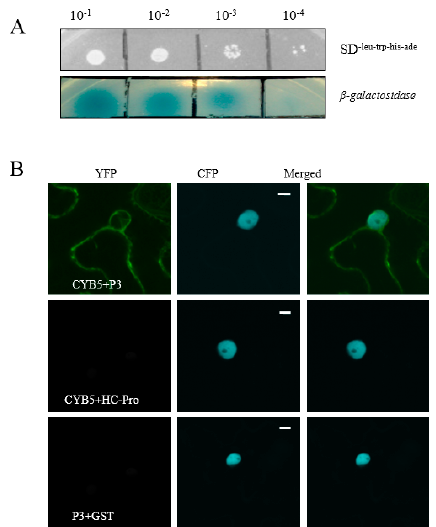
Figure 1. GmCYB5-1 interacts with the P3 protein of soybean mosaic virus (SMV). ( A ) Interaction of SMV-P3 and GmCYB5 in yeast growing on selective medium SD -leu-trp-his-ade with X- α -gal at different concentrations. Images are representative two independent experiments for each interaction. ( B ) Bimolecular florescence complementation (BiFC) micrographs of 40 × magnification at 48 h post-infiltration from plants co-expressing nYFP-GmCYB5 and cYFP-P3, with cYFP-HC-Pro and cYFP-GST are negative controls. Transgenic Nicotiana benthamiana, expressing CFP-H2B (nuclear localized histone 2B), were used for the BiFC assays. Images are representative of three separate infiltrations from two independent experiments for each interaction using both combinations of n / cYFP fused proteins. Scale bars: 10 μ m.